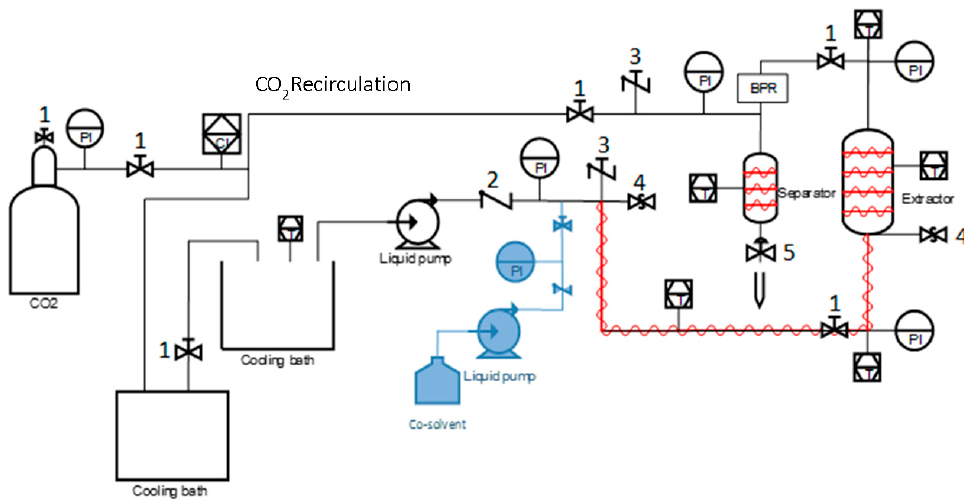
Figure 2. Schematic diagram of the SFE apparatus. 1—Needle valve; 2—Check valve; 3—Safety rupture disc; 4—Relief valve; 5—Sample collection valve. BPR—Back pressure regulator.